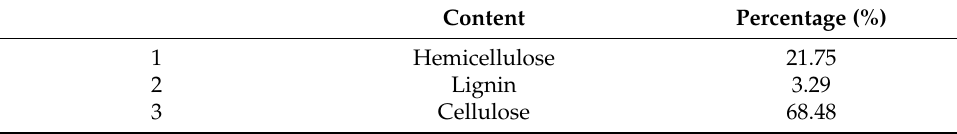
Table 1. Chemical composition of woven kenaf.